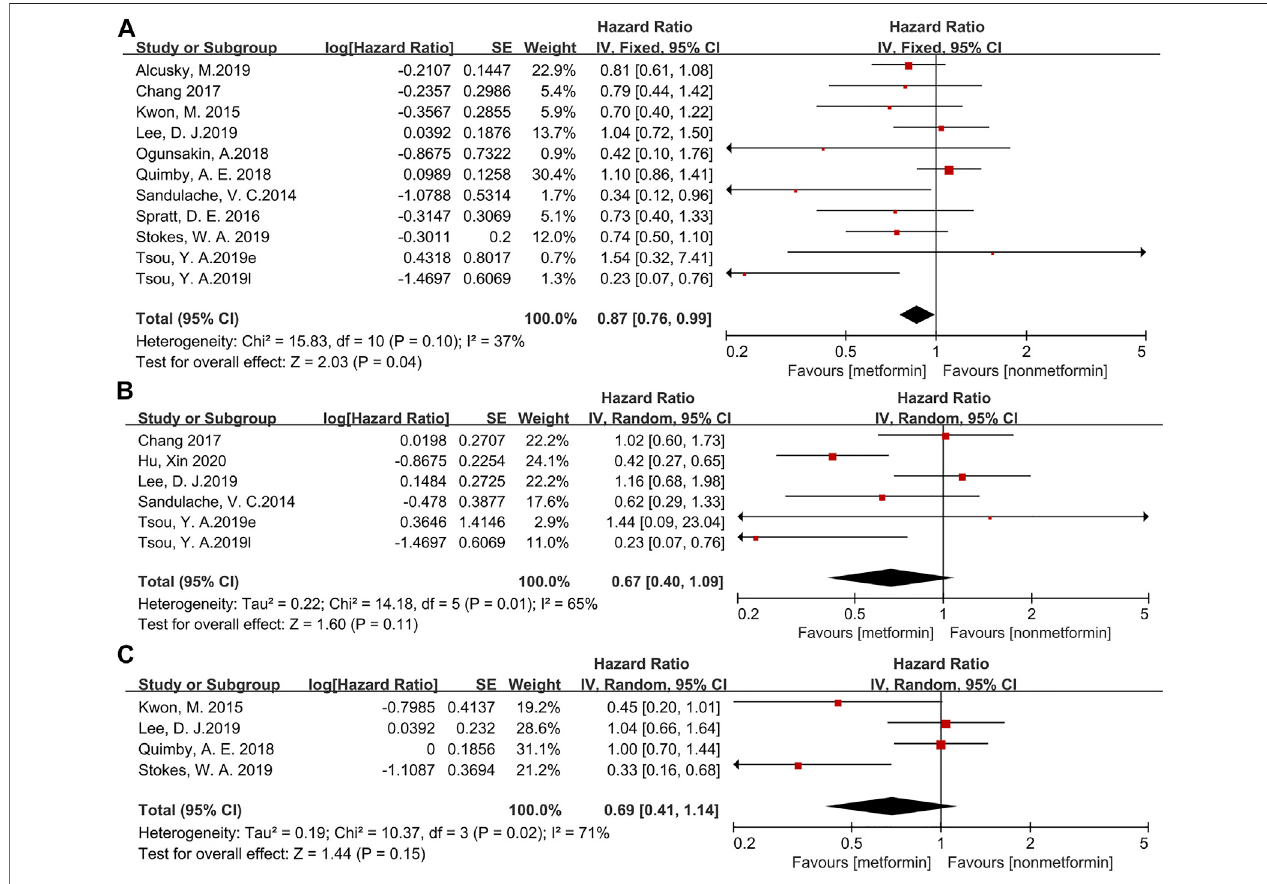
FIGURE 2 | The forest plot of head and neck cancer according to metformin use for overall survival (A) , disease-free survival (B) , disease-speci fi c survival (C) .